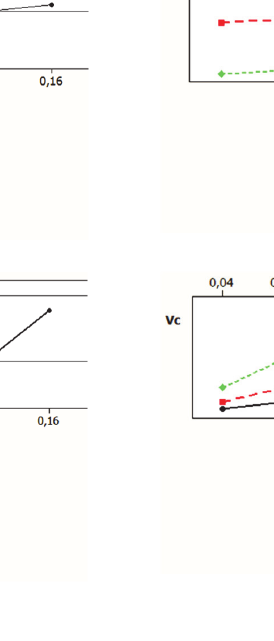
Fig. 2. Main plot effects and interactions plot for Ra ( a. b ), MRR ( c. d )